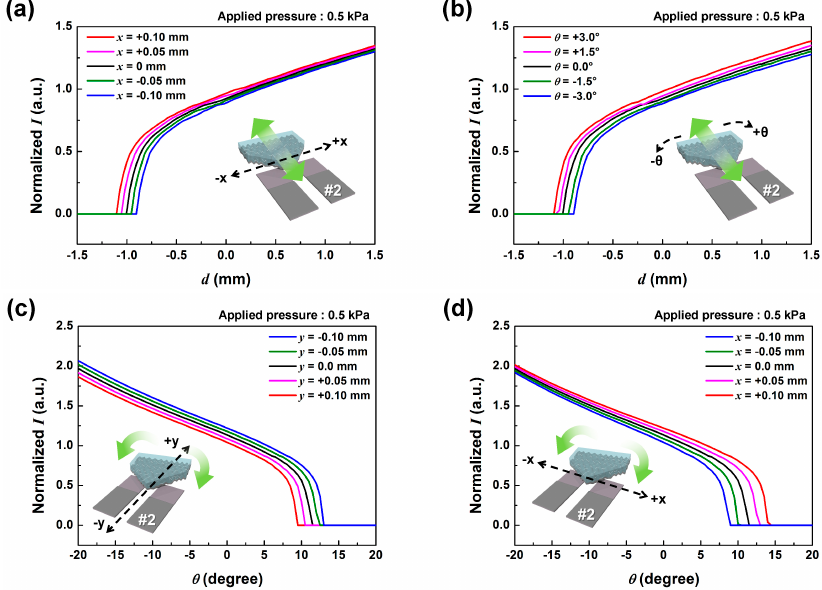
Figure 4. The effect of out-of-axis movements of SMP on sensor detection; the simulated displacement sensing error of electrode no. 2 depending on ( a ) the lateral displacements of ±100 μ m with 50 μ m interval, and ( b ) the rotation angles of ±3 degrees with a 1.5 degree interval, and the simulated rotation angle sensing error of electrode no. 2 depending on ±100 μ m displacement error with 50 μ m intervals for ( c ) the parallel and ( d ) lateral movements. The insets show the schematic illustrations of dSMP sensor movement, the green arrows show the movement direction, and the black dash lines show the axes of the initial position error.